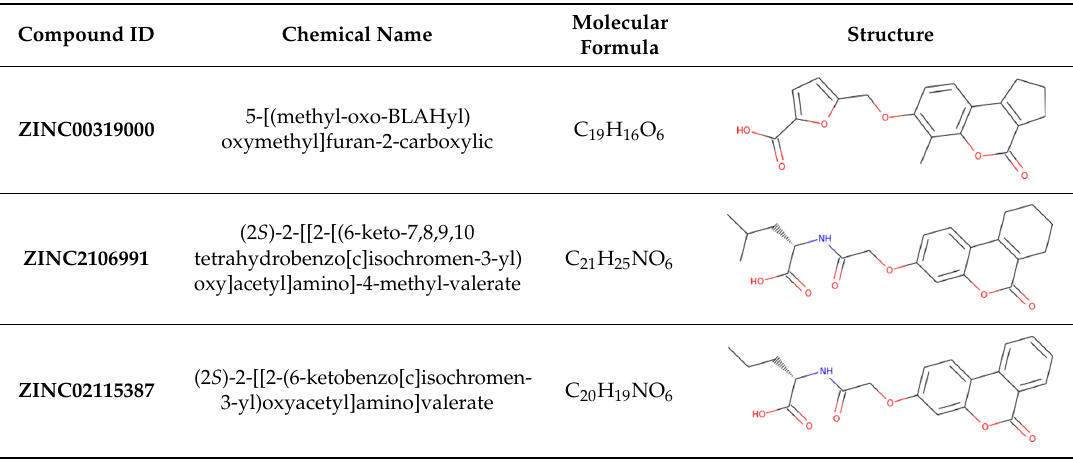
Table 5. List of the identified compounds along with known SGK1 inhibitors (EMD638683 and GSK650394) and their chemical